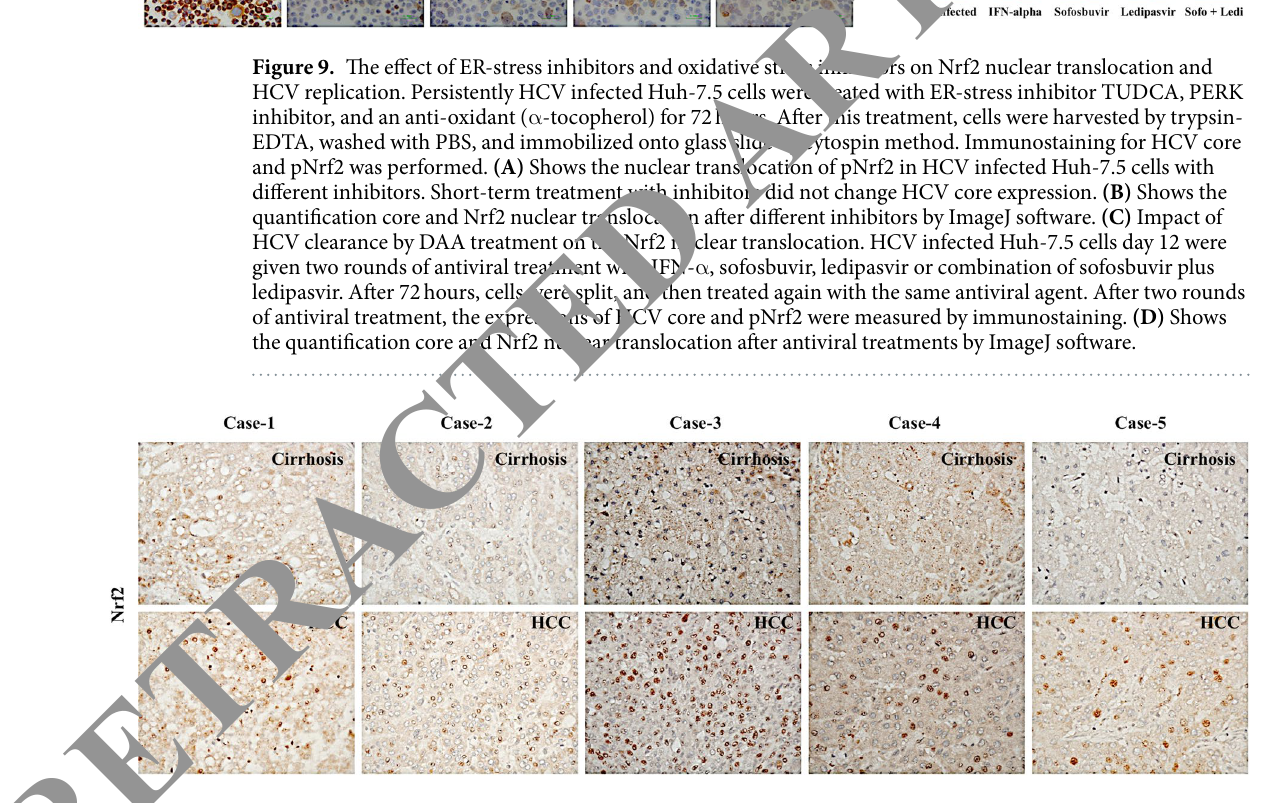
Figure 10. The expression of Nrf2 was examined using paraffin-embedded tissue sections of five HCV infected cirrhotic liver with HCC by immunohistochemical staining. Nuclear translocation of Nrf2 was seen only in the tumor areas of HCV infected liver cirrhosis with HCC. Most of the non-tumorous hepatocytes in the cirrhotic liver show negative nuclear Nrf2